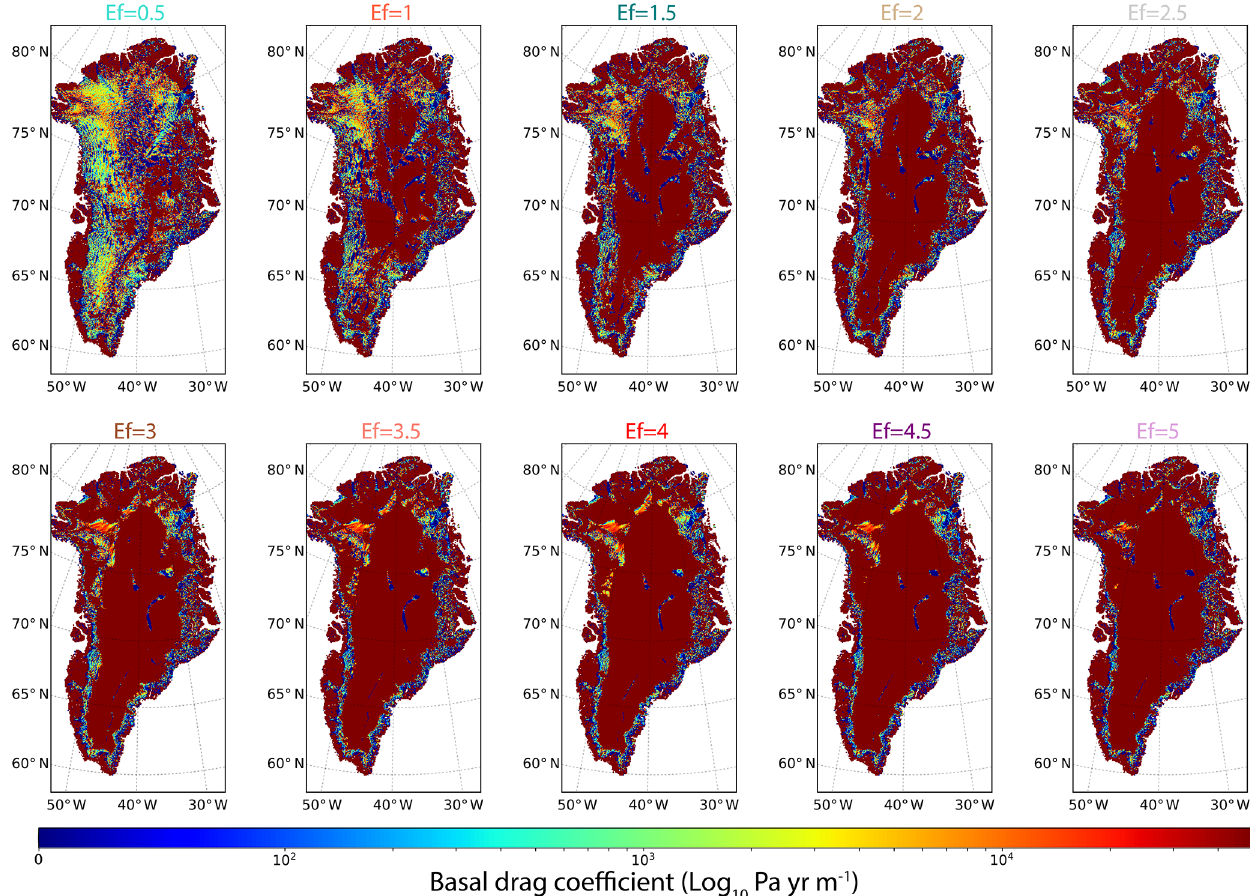
Figure 7. Spatial distribution of the basal drag coefficient (log 10 Pa yrm − 1 ) for Ef ranging from 0.5 to 5 for the iterative cycle Nb cycle that produces the lowest RMSE (Table 1). Here, Nb inv and Nb free are set to 20 and 200 years